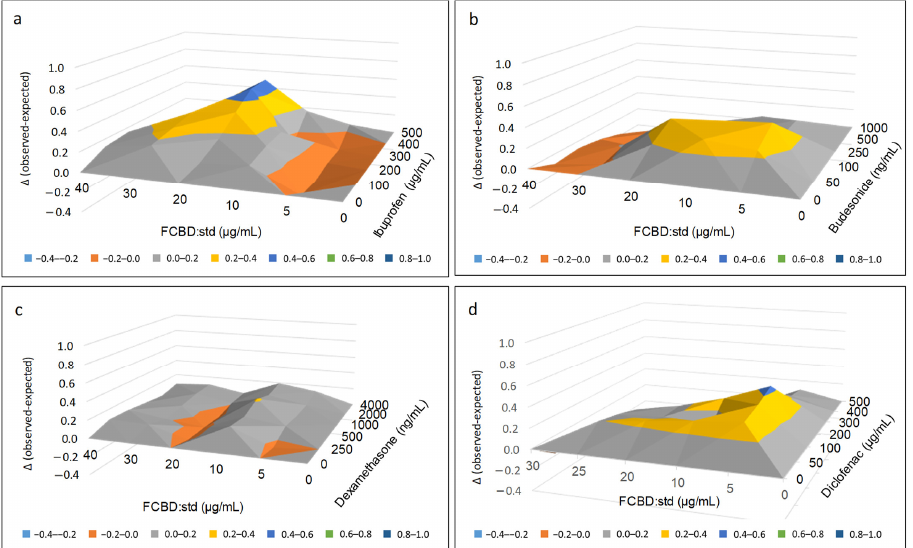
Figure 2. Synergistic interactions between FCBD:std with ( a ) ibuprofen, ( b ) budesonide, ( c ) dexamethasone or ( d ) diclofenac on IL-8 level of A549 cells following combined treatments. The Bliss independence-drug interaction model was used to calculate synergy. Synergy is determined when the experimental value of IL-8 reduction is higher than the calculated value. In the Y axis is the delta between the experimental and the calculated values. In Supplementary Table S2, different letters indicate significantly different levels of the experimental (observed) values from all pairs’ combinations according to Tukey–Kramer honest significant difference test ( n = 3; HSD; p ≤ 0.05). Treatments with 5 or 20 µg/mL of FCBD:std and 100 ng/mL budesonide resulted in activity that was 1.8 and 2.0-fold higher, respectively, than budesonide alone. The concentration of 10 µg/mL of FCBD:std with 50 or 100 ng/mL budesonide resulted in 1.5 and 1.6-fold higher activity, respectively, than budesonide alone (Supplementary Table S3b). Similarly, treatment with FCBD:std and budesonide at these concentrations led to significant synergy (Figure 2b; Supplementary Table S3b). Treatments with FCBD:std and dexamethasone lead to only a minor increase in activity (Supplementary Table S3c), significant synergy was detected mainly at 10 µg/mL FCBD:std combined with 1000 ng/mL dexamethasone (Figure 2c; Supplementary Table S3c). Treatments with 5 µg/mL FCBD:std and 50, 100, 200, and 300 µg/mL of diclofenac showed 1.4, 1.5, 1.8 and 1.5-fold higher activity than diclofenac alone, respectively